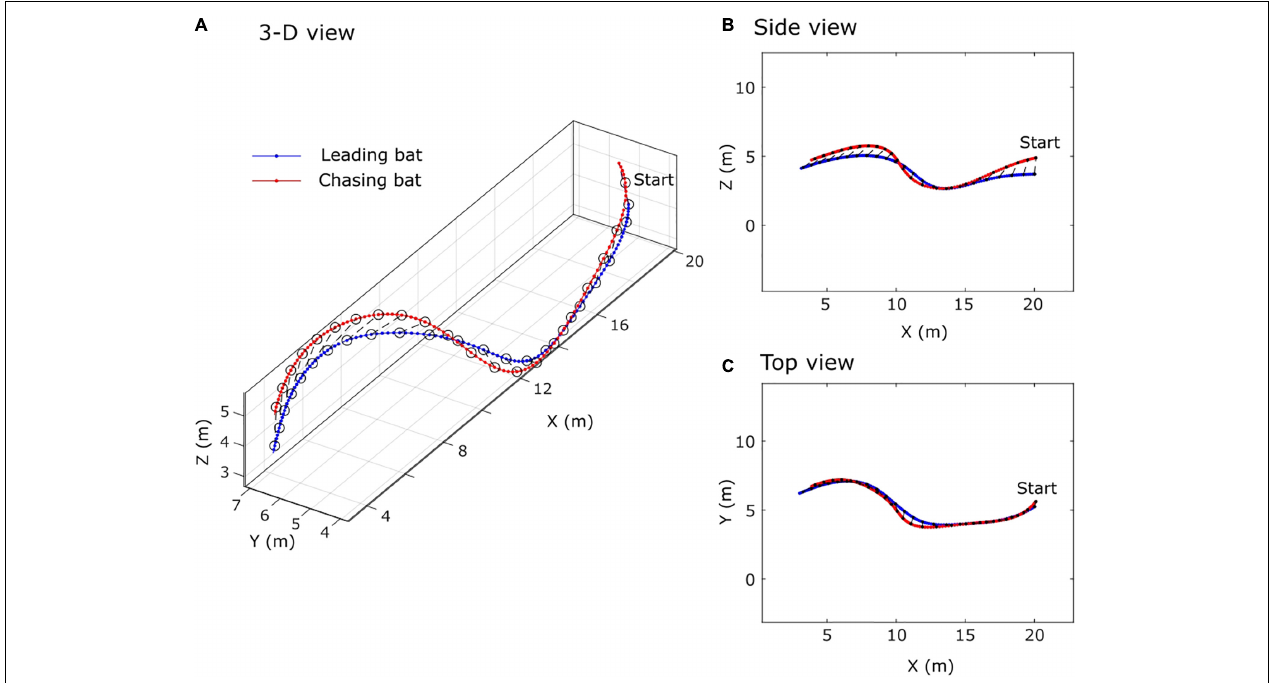
FIGURE 3 | Example chasing sequence observed during song production. (A) 3-D perspective, (B) profile or side view, (C) top view. Note that the red bat remains slightly behind the blue bat throughout the sequence and makes slightly wider turns, which are indicative of chasing behavior.